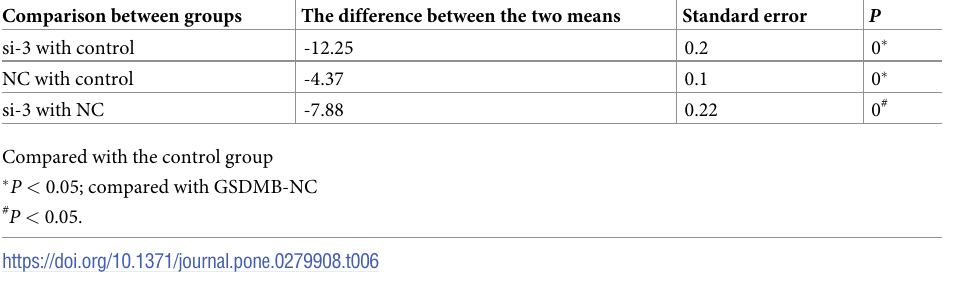
Table 6. Apoptosis rate detected by flow cytometry (%). Comparison between